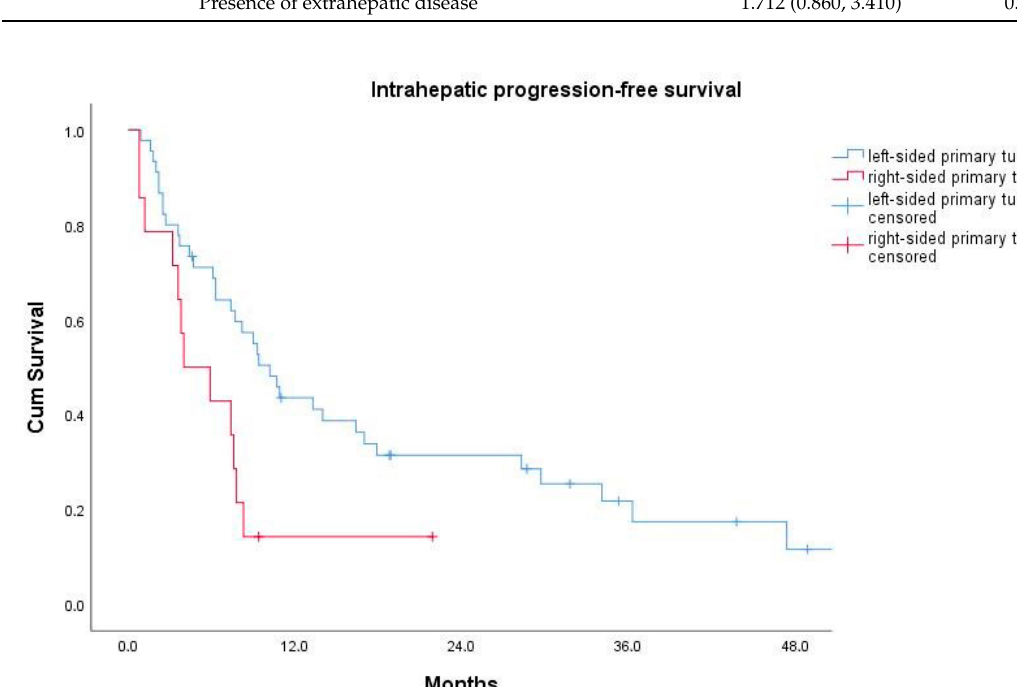
Figure 2. Kaplan–Meier curves for intrahepatic progression-free survival for patients with a left-sided (blue curve) vs. those with a right-sided (red curve) primary tumor .